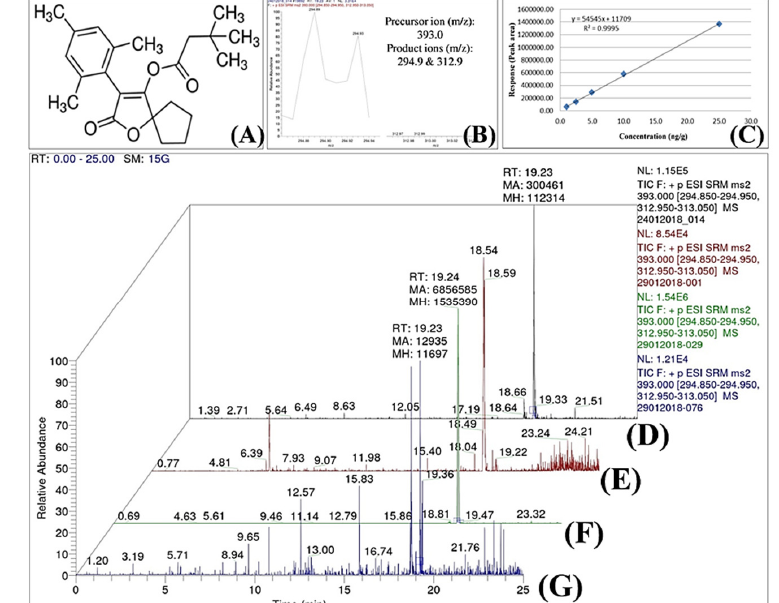
Figure 1. Optimization of chromatographic separation on UHPLC-MS/MS SRM of spiromesifen (A) Chemical structure (B) Optimized precursor and product (m/z) ions (C) Specificity with linear response. UHPLC-MS/MS SRM three dimensional chromatograms of spiromesifen (D) at standard 0.005 mg/kg (E) in control (F) on 0 (2hr) day and (G) on 3 rd day after spiromesifen application in brinjal fruit sample at recommended dose;